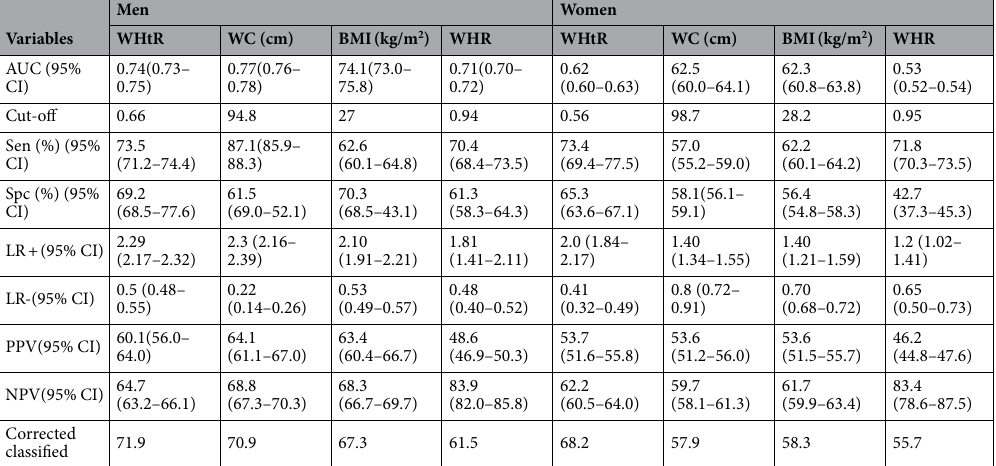
Table 3. Area under the receiver operating characteristic curve (and 95% confidence interval) and optimal cut-off values of diagnostic measures of anthropometric indices against Metabolic syndrome stratified by sex. AUC area under the ROC curve, Sen sensitivity, Spc specificity, LR likelihood ratios, PPV positive predictive value, NPV negative predictive value, WC waist circumference, BMI body mass index, WHR waist to hip ratio, WHtR waist to height ratio. There is no significant difference among AUCs ( df = 3) = 130, P = < 0.001, ( df = 3) = 336, P = < 0.001 in men and women respectively. Data are AUC (95% confidence